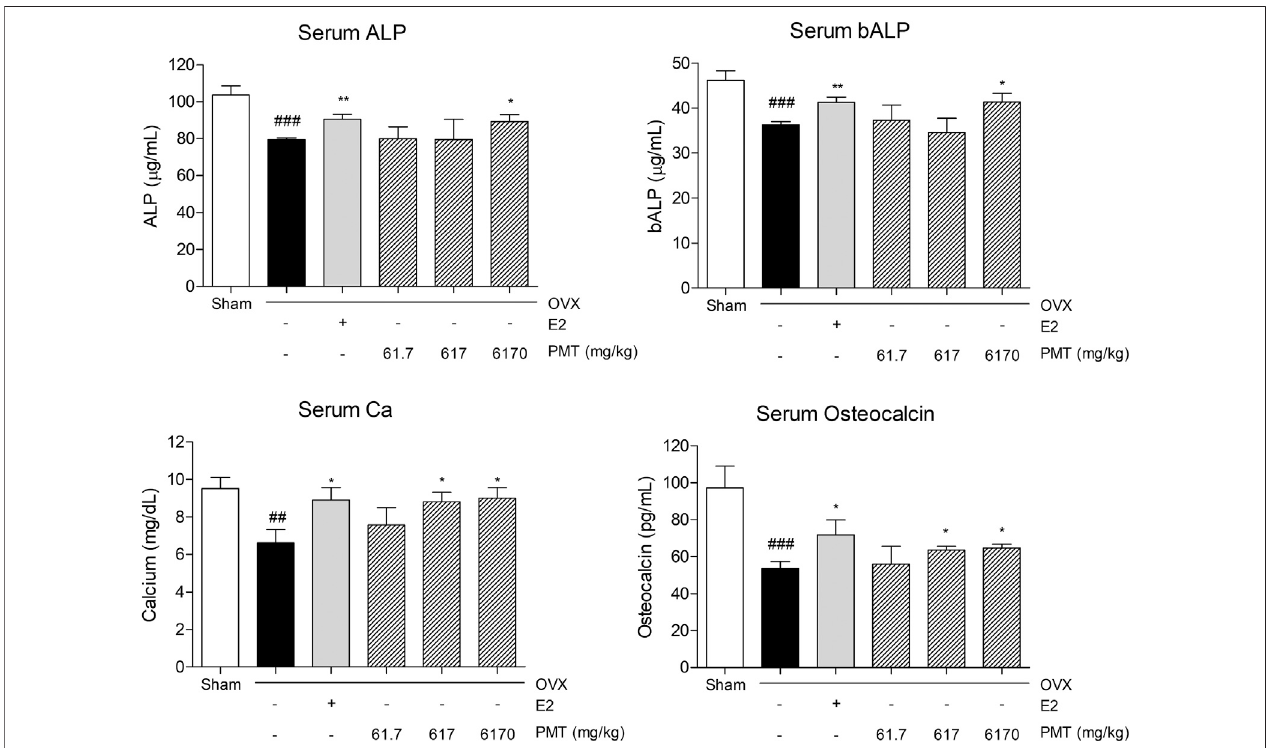
FIGURE 3 | Effects of PMT on bone speci fi c markers in serum. Secretion of bone speci fi c markers in serum was analyzed by ELISA. Results are presented as the mean ± standarderror. ## p < 0.01and ### p < 0.001vs.Shamgroup;* p < 0.05and** p < 0.01vs.OVXgroup.OVX,ovariectomizedgroup;E2,17 β -estradiolgroup;PMT, Palmul -tang soft extracts; ALP, alkaline phosphatase; bALP, bone-speci fi c alkaline phosphatase.